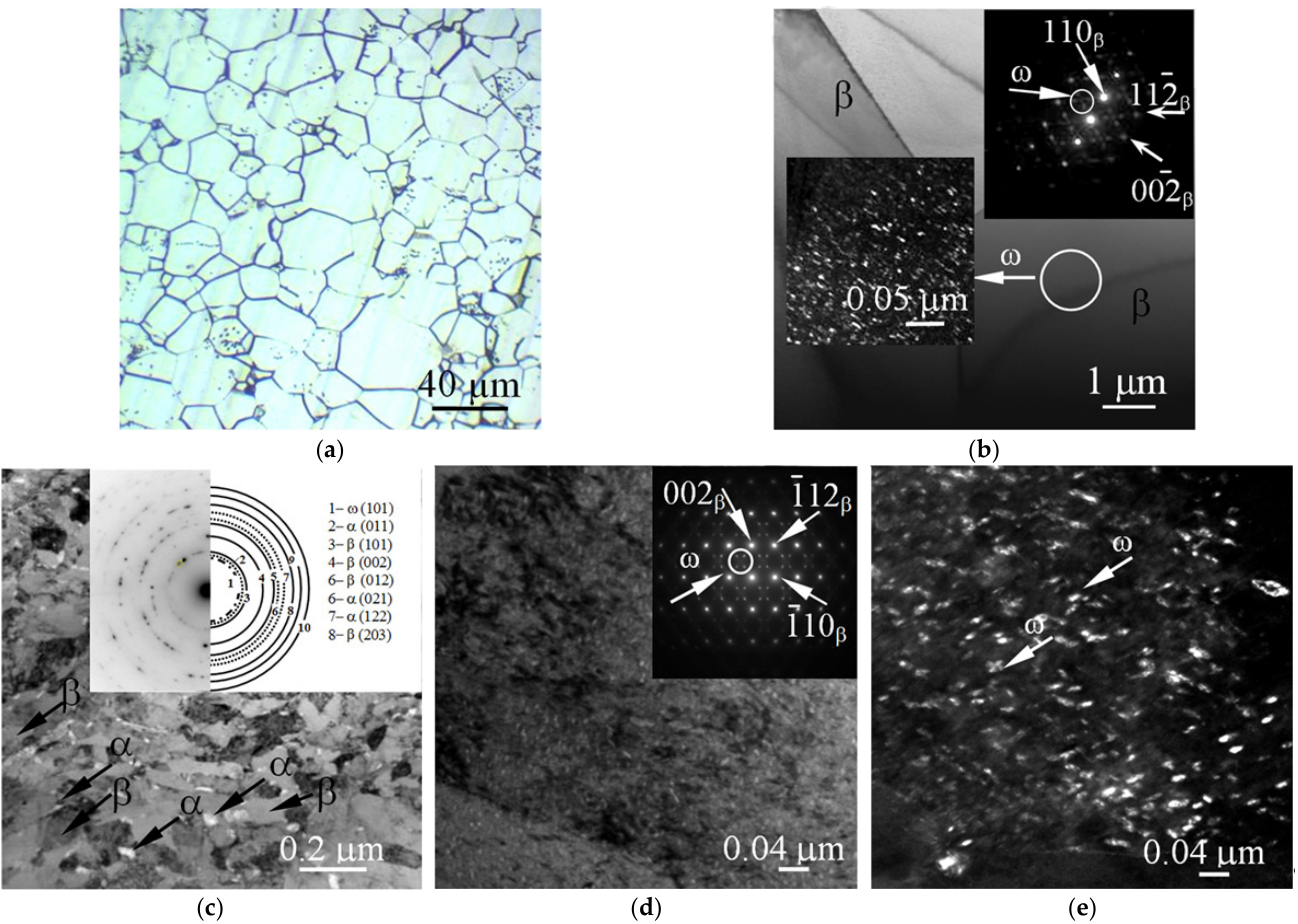
Figure 5. ( a ) Optical micrograph, ( b – d ) bright-field TEM micrographs with SAD patterns, and ( b , e ) dark-field TEM micrographs of CG ( a , b ) and UFG Ti-45Nb samples ( b – e ).